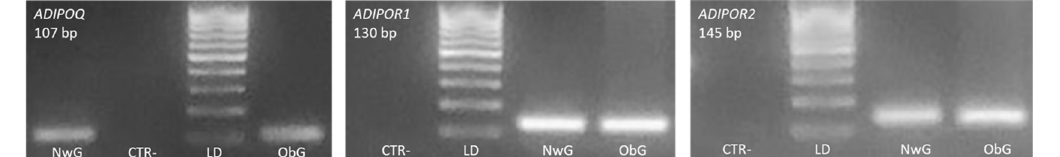
Figure 1. Representative photographs of typical 2% agarose ethidium bromide stained gels. The presence of the expected bp products yielded after RT-qPCR using primers for target ADIPOQ and its receptors ( ADIPOR1 and ADIPOR2 ) are shown. Lane LD is the kilobase DNA marker, CTR- is the negative control, lane NwG (normal weight group) and ObG (obese group) identify two skin samples belonging to the two experimental groups.